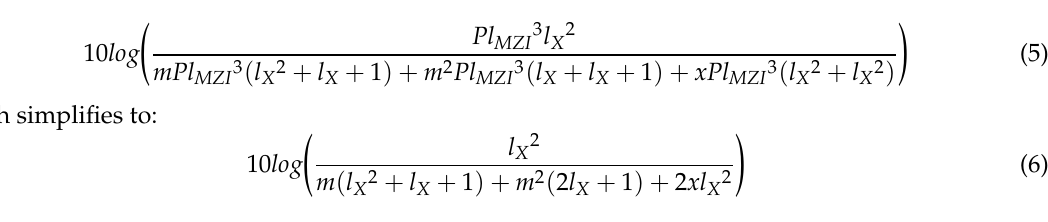
Figure 6. 4 × 4 —Beneš, all MZIs are in bar-state. Figure 6. 4 × 4–Beneš, all MZIs are in bar-state.